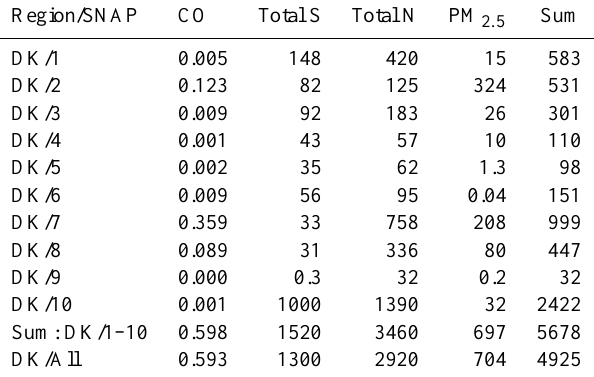
Table 3. Total number of cases of the different impacts related to all Danish anthropogenic emissions (scenario: all) for the year 2000. Health impact Number of cases in Europe Number of cases in Denmark Chronic bronchitis 4350 802 Restricted activity days 4440000 820000 Respiratory hospital admissions 234 44 Cerebrovascular hospital admissions 556 101 Congestive heart failure 324 69 Lung cancer 666 123 Bronchodilator use, children 128000 21600 Bronchodilator use, adults 851000 157000 Cough, children 441000 74600 Cough, adults 876000 162000 Lower respiratory symptoms, children 170000 52800 Lower respiratory symptoms, adults 316000 58300 Acute mortality 85 − 9 Chronic mortality (YOLL) 49000 8520 Infant mortality 5